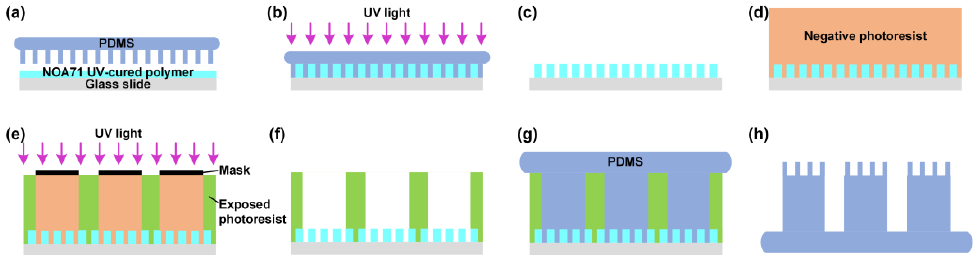
Figure 1. Schematic diagram of photolithography and micromolding process to fabricate hierar- chical structures: ( a – c ) imprinting the secondary structure template, ( d – f ) forming the hierarchical microhole array by UV-lithography, ( g , h ) molding to obtain the PDMS hierarchical structure.